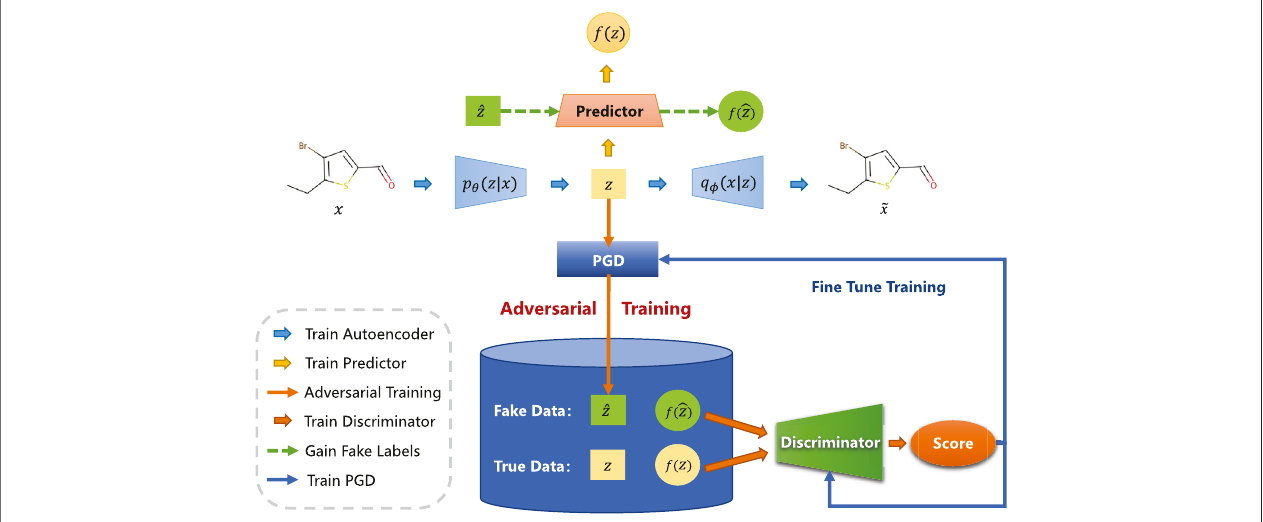
FIGURE2| Illustrationoftheoverallarchitecture.CRAGconsistsofanadversariallyregularizedencoder-decoderblock,apropertypredictorblock,andaprojected gradient descent block. In particular, p θ ( z | x ) and q ϕ ( x | z ) denote the probabilistic encoder and the probabilistic decoder. The property prediction network f ω is used to predictthepropertyofmolecules.Projectedgradientdescentblockgeneratesadversarialsamples ^ z andlabels f ( ^ z ) .Thediscriminatorisonlyusedinthetrainingprocess to enforce